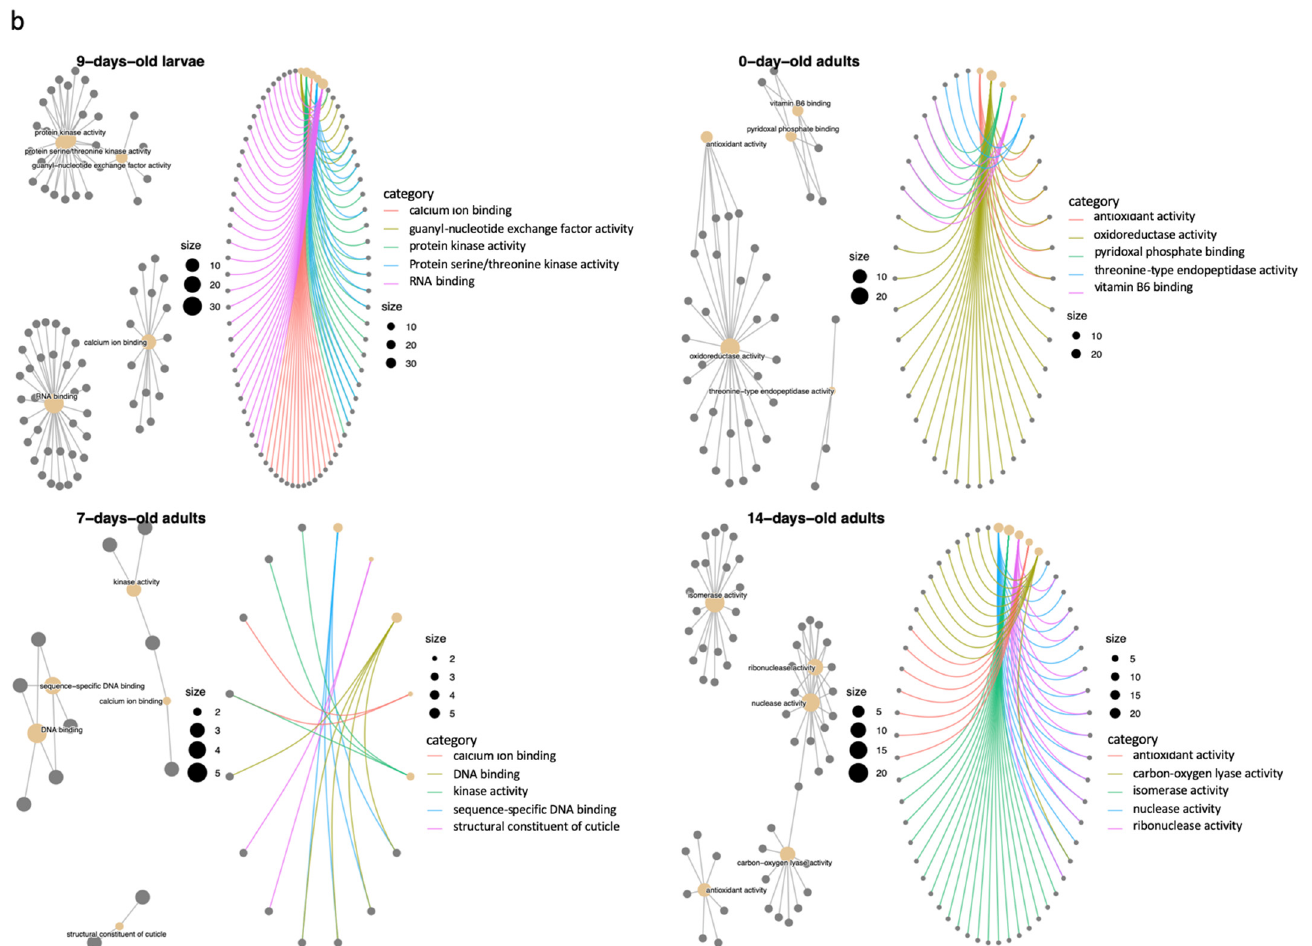
Figure 2. Gene-pathway concept network for overrepresentation testing for GO terms in the pool of ( a ). upregulated and ( b ). downregulated DEGs among different imidacloprid treatments in 9-day-old larvae, 0-day-old adults, 7-day-old adults, and 14-day-old adults. Size: number of DEGs; category: the GO terms category. Gray lines indicate the network connection, and the weight of the line reflects the degree of connection between terms. Colored lines indicate the connection between terms and the involved genes. The concept network plot shows that the genes are involved in significant terms and biological complexness.